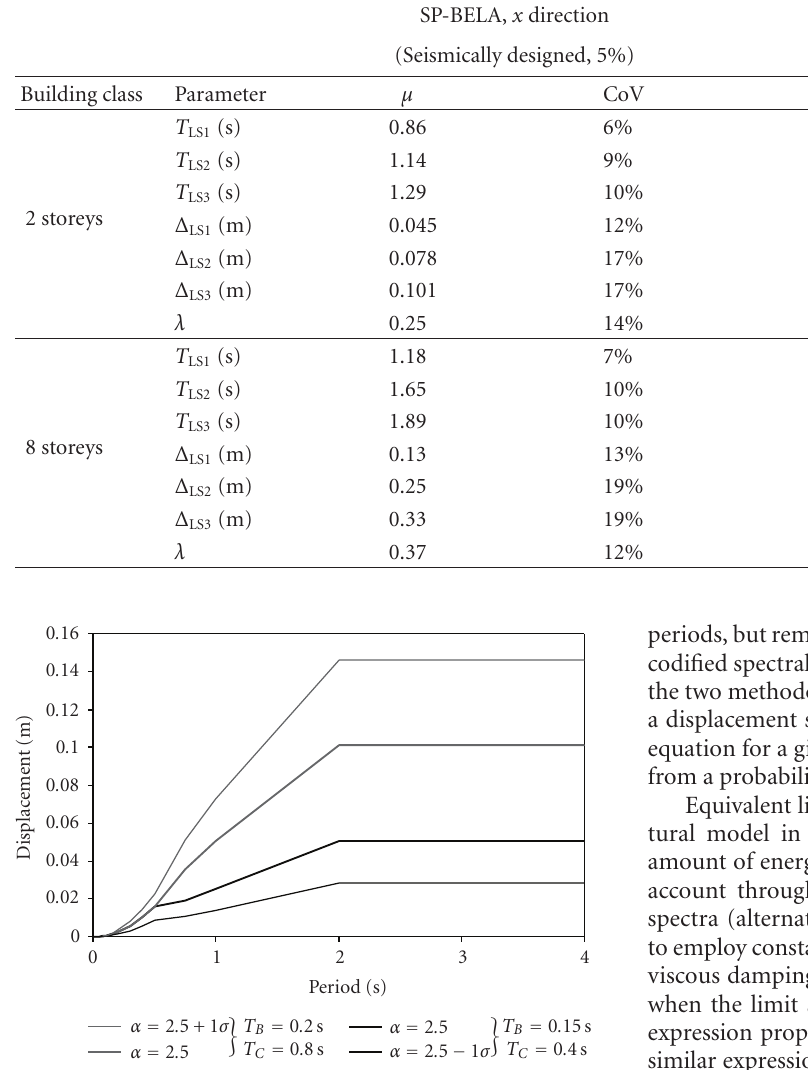
Figure 16: Upper and lower bound mean displacement spectral shapes due to variation of the characteristic periods (in bold). The thin lines show the upper bound spectrum +1 σ and the lower bound spectrum − 1 σ that represents the variability in the coe ffi cient α